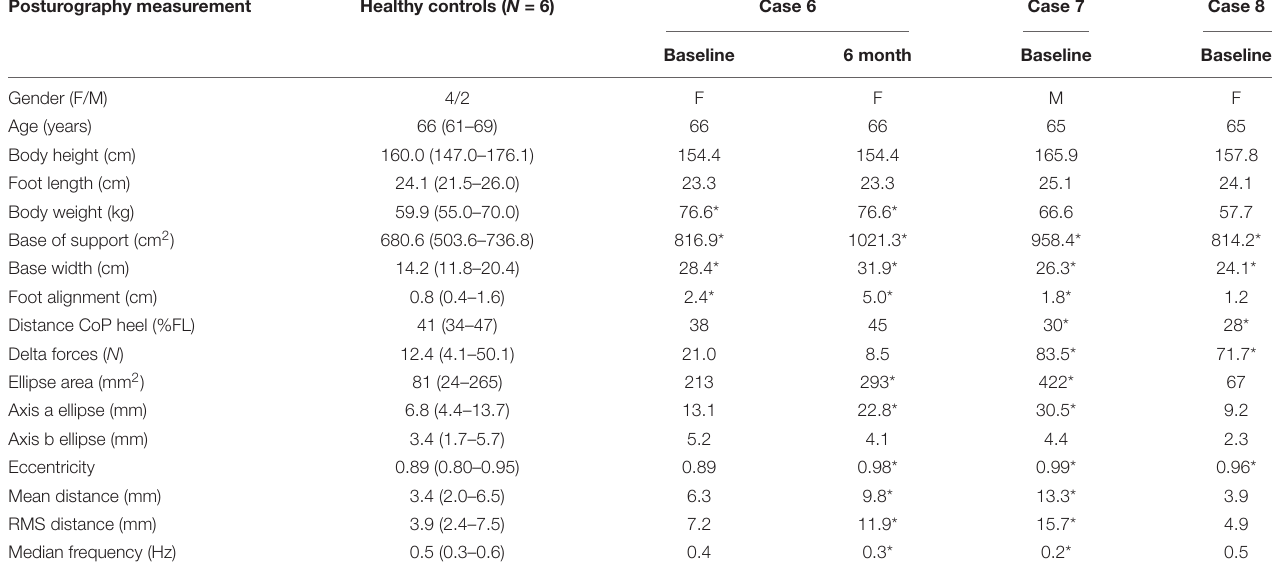
TABLE 3 | Posturographic